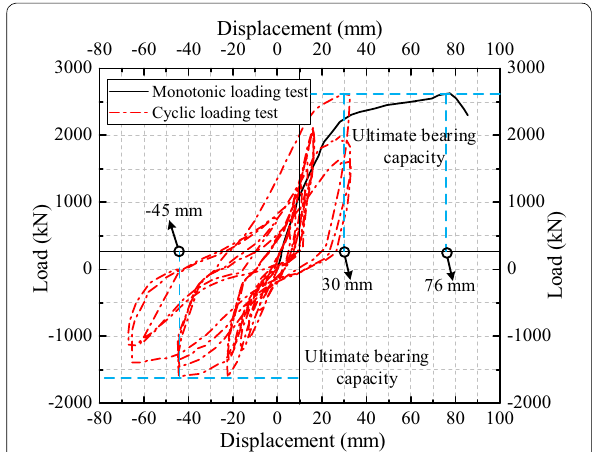
Fig. 12 Load vs. displacement curves for the monotonic and cyclic loading